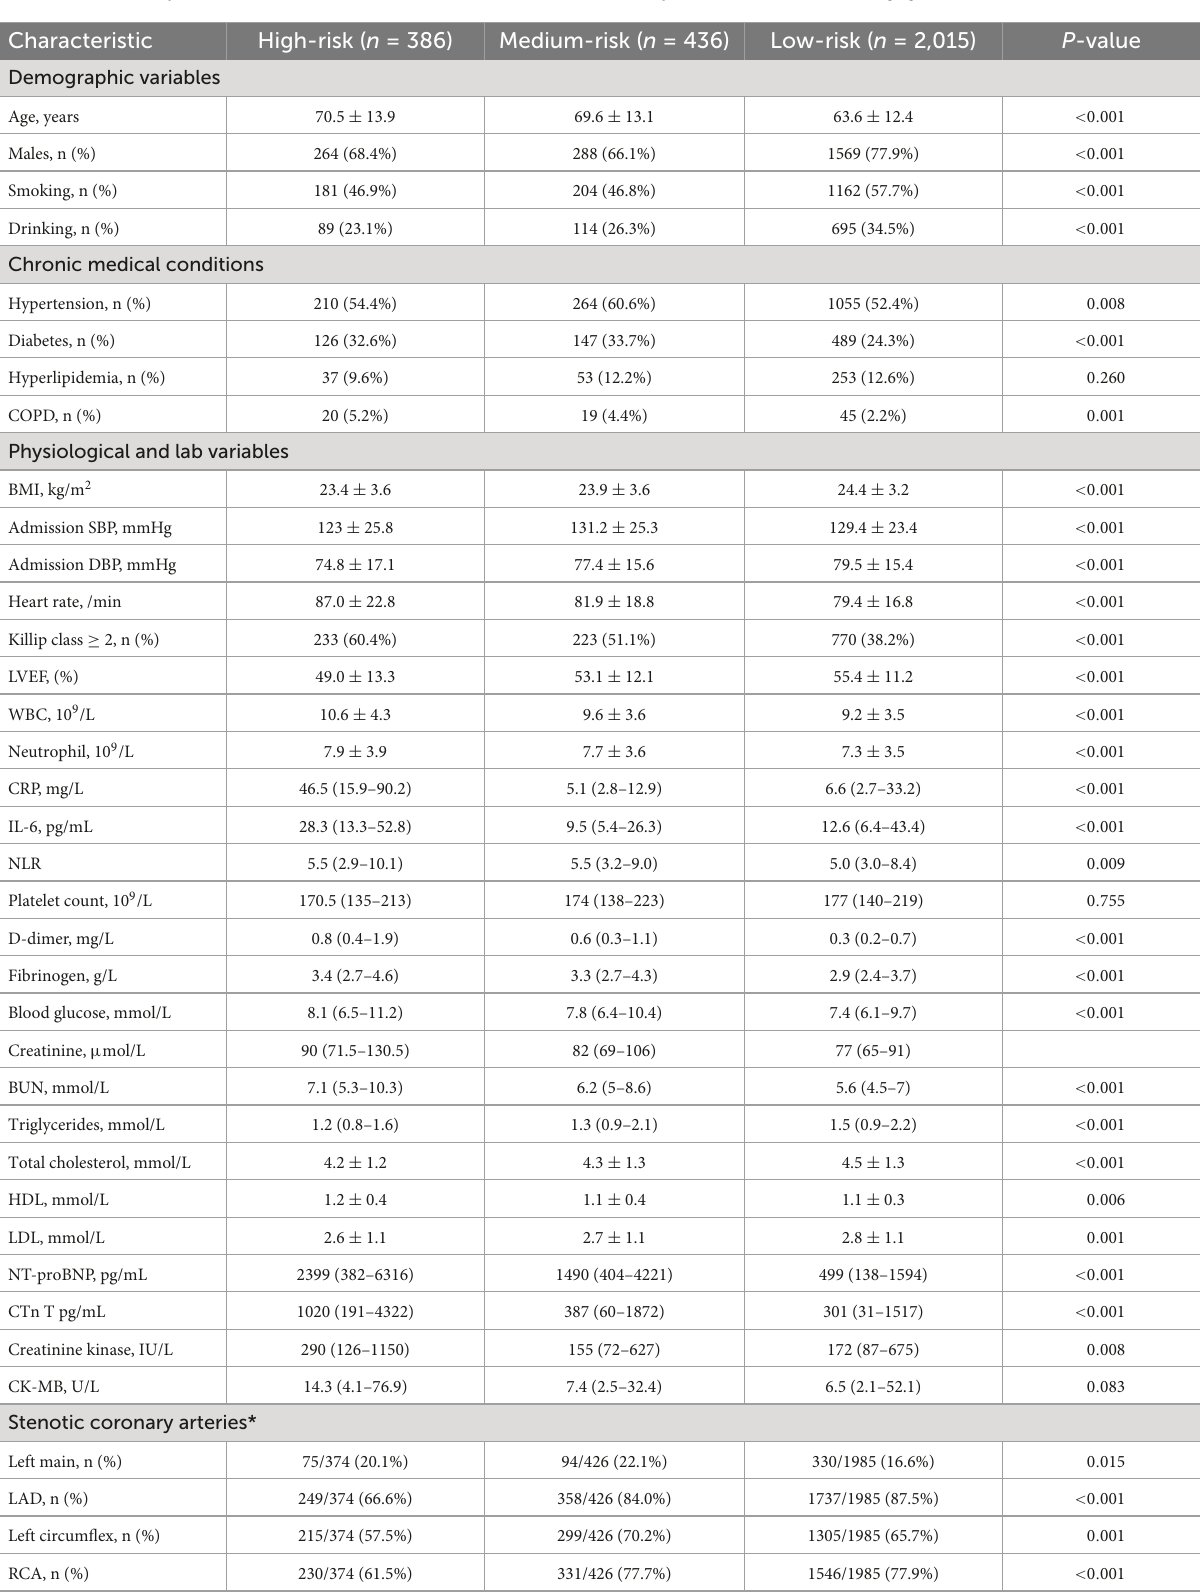
TABLE 1 Relationships between baseline clinical characteristics and the DBRP in patients with acute coronary syndrome. Characteristic High-risk ( n = 386) Medium-risk ( n =